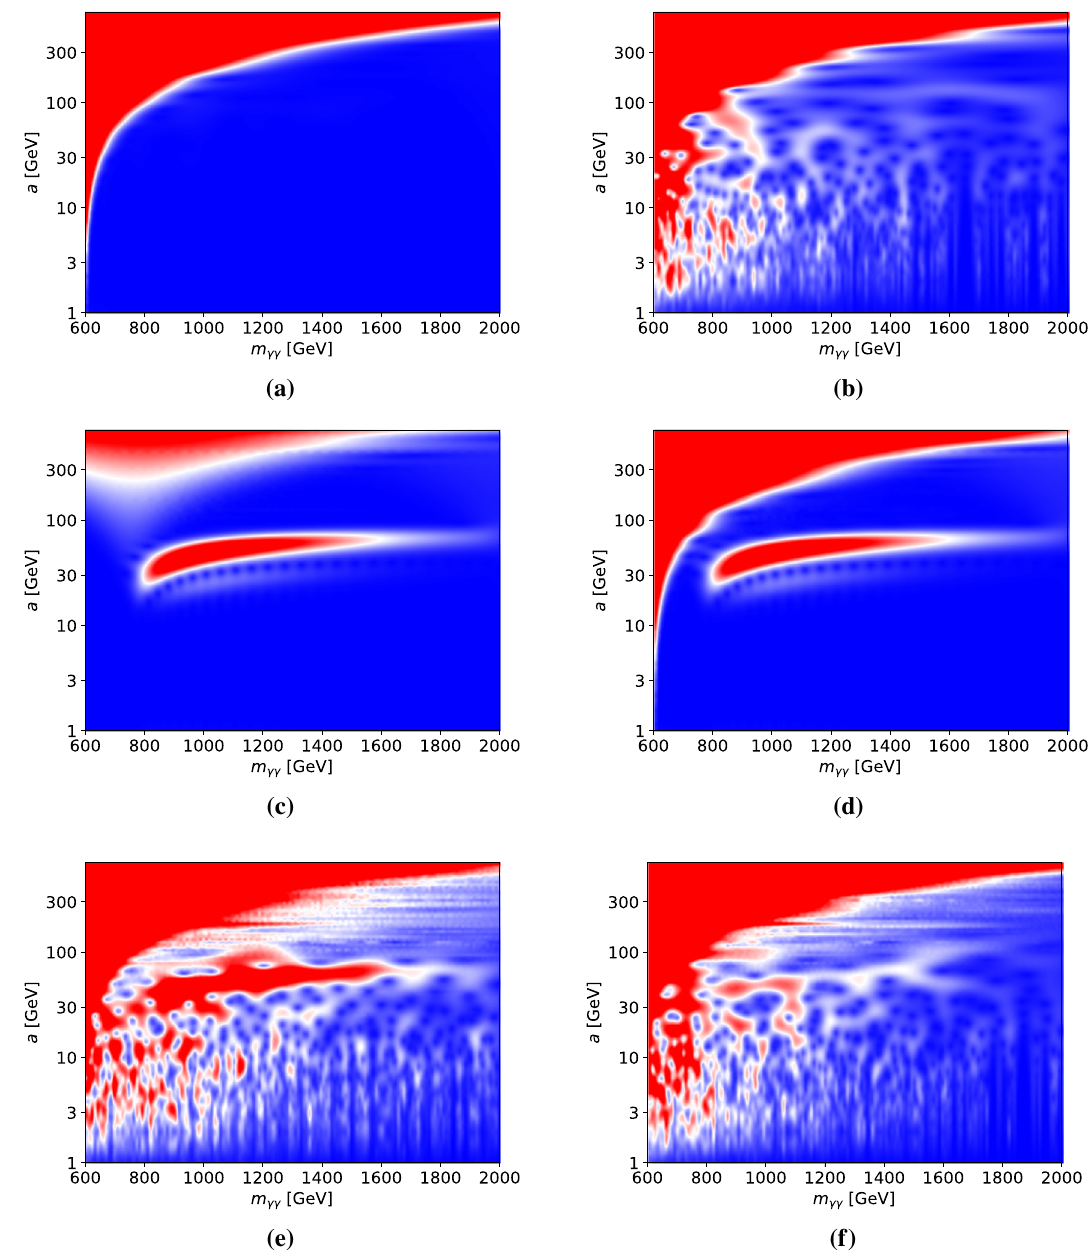
Fig. 2 Examples of scalograms for the CW/LD with k = 750 GeV. a CWT of the smooth falling background from Ref. [10] without sta- tistical fluctuations. b CWT of the background with statistical fluctu- ations. c CWT of the signal alone, without statistical fluctuations, for